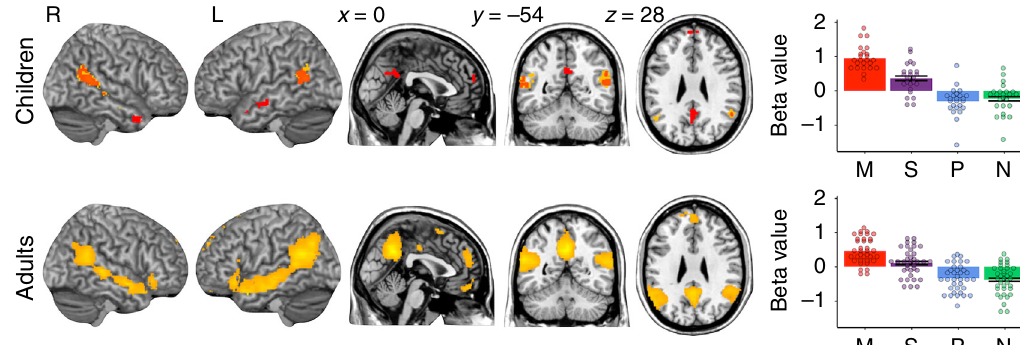
Fig. 2 Theory of mind brain regions preferentially respond to ASL stories that describe mental states. Brain images show results of whole-brain random effects analyses for all children ( n = 24, top row) and adults ( n = 36, bottom row) for the Mental > Physical stories contrast (one-sample t tests). Clusters that survive correction for multiple comparisons using permutation analyses (SnPM; P < 0.05) are shown in orange; red clusters show activation where P < 0.001, k = 10, uncorrected for multiple comparisons (children only); see Table 1 for further information about signi fi cant clusters. Bar plots show average beta-value estimates per condition + / − SEM (Mental (red), Social (purple), Physical (blue) stories, and Non-Signs (green) in individually de fi ned functional ToM regions of interest (ROIs; averaged across bilateral temporoparietal junction, precuneus, and dorso-, middle-, and ventromedial prefrontal cortex); dots show individual data points per participant. The adult non-sign condition bar refers to the 8-Non-Sign condition (see Methods). Error bars are omitted for Mental and Physical conditions because these conditions were used for individual ROI de fi nition. See Supplementary Fig. 2 for similar plots in group regions of interest. Source data are provided as a Source Data fi le and at https://osf.io/kyu3f/.